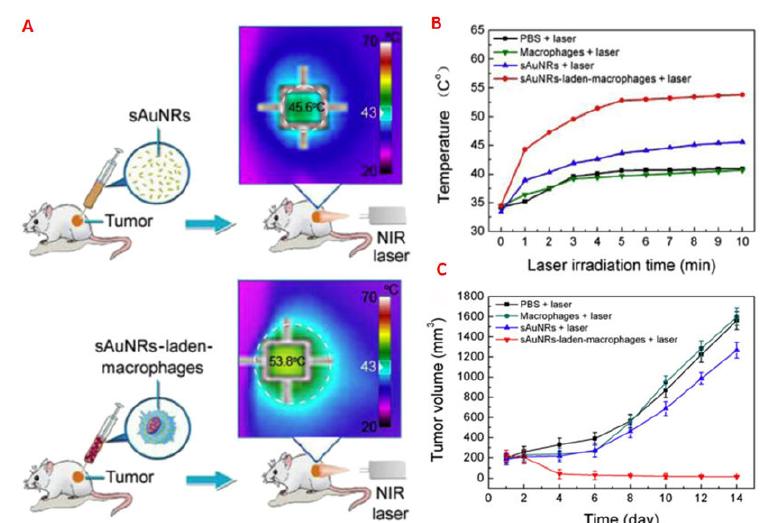
Figure 12. ( A ) Schematic showing the distinction between the treatment of small free gold nanorods and small gold nanorods charged with macrophages; ( B ) tumor temperature profile below 808 nm light for 10 min; and ( C ) tumor growth after irradiation therapy in different mice classes [42,84]. Reprinted with permission from ref. [42,84]. Copyright 2007, 2016 Biosensors and